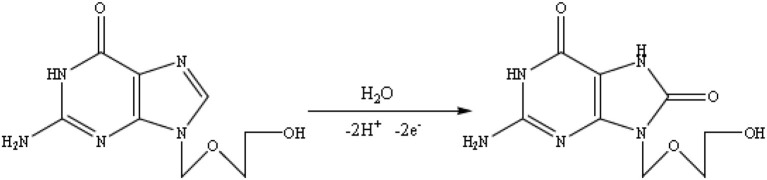
The ACV oxidation mechanism.